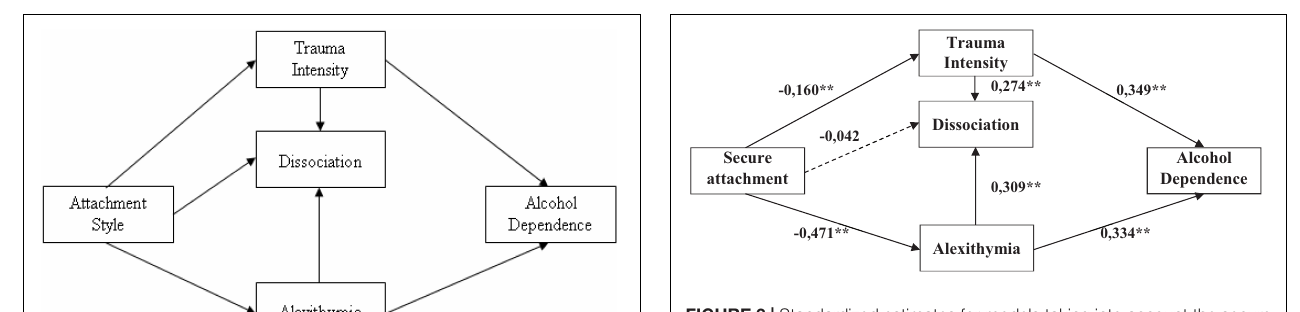
FIGURE 3 | Standardized estimates for models taking into account the secure attachment style (dashed lines marked not significant paths). Source: TABLE 6 | Standardized estimates with 95% confidence intervals for models taking into account the anxious-ambivalent attachment style.